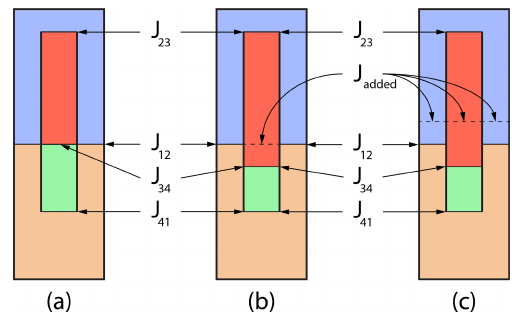
Figure 9. General diagram for techniques to achieve flat foldability with a deploying strut ThUDS: (a) joint alignment, (b) split-strut, and (c) double-split link. Joints match those shown in Figs. 2 and 5.